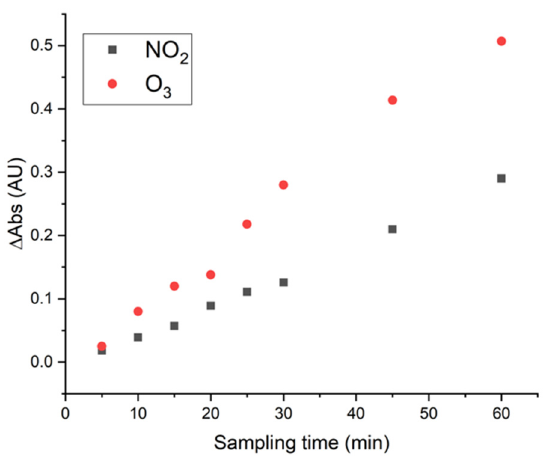
Figure 4. The effect of sampling time in the analytical signal for ozone and nitrogen dioxide determination.